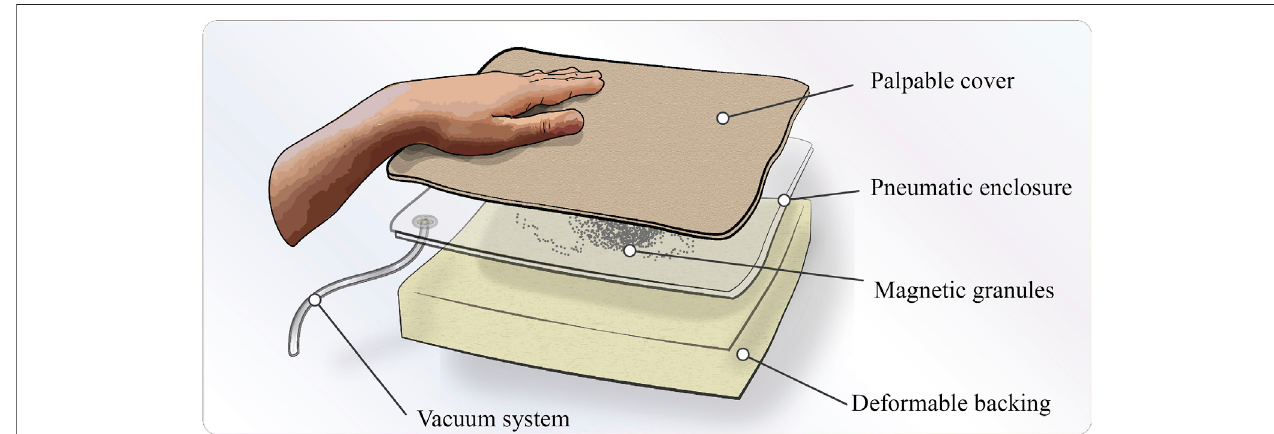
FIGURE 1 | Descriptive illustration of the haptic interface concept.